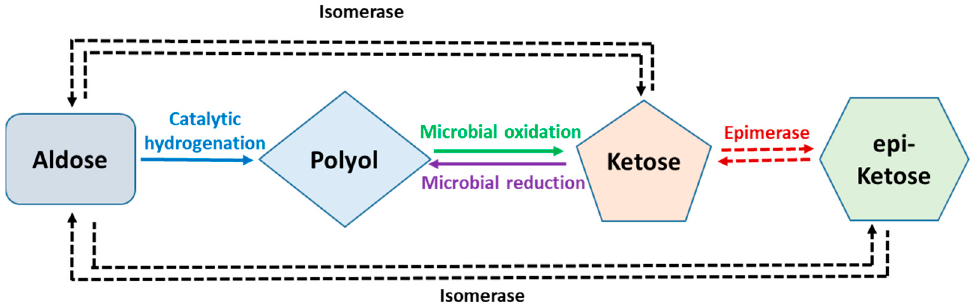
Figure 1. Strategy for interconversion of all the monosaccharides developed by Izumori group; modified from Best et al. [17].